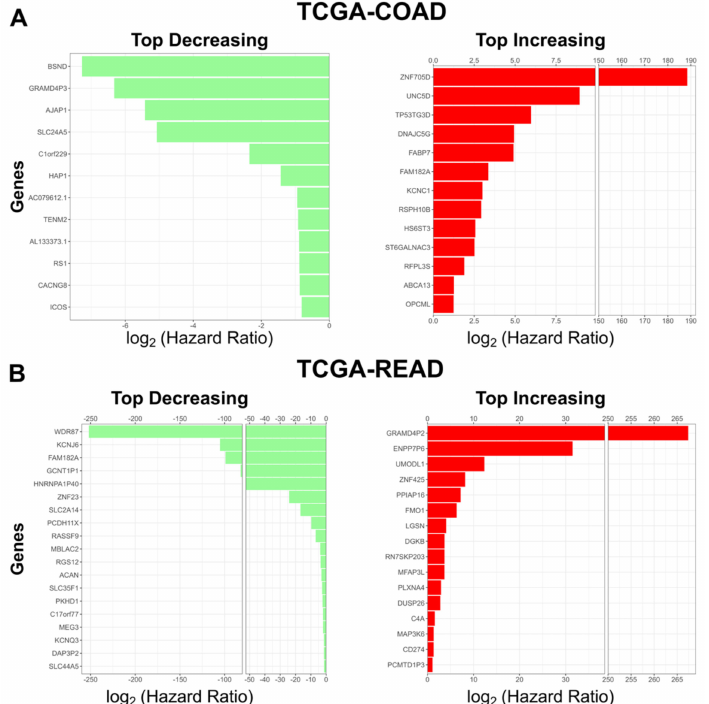
Figure 4. Top coefficients identified by our model. ( A ) Top risk decreasing (green, left) and top risk increasing (red, right) genes identified by our Cox model in TCGA-COAD. ( B ) Top risk decreasing genes (green, left) and top risk increasing (red, right) genes identified by our Cox model in TCGA- READ. For risk increasing genes the hazard ratio threshold is > 2. For risk decreasing genes the hazard ratio threshold is <